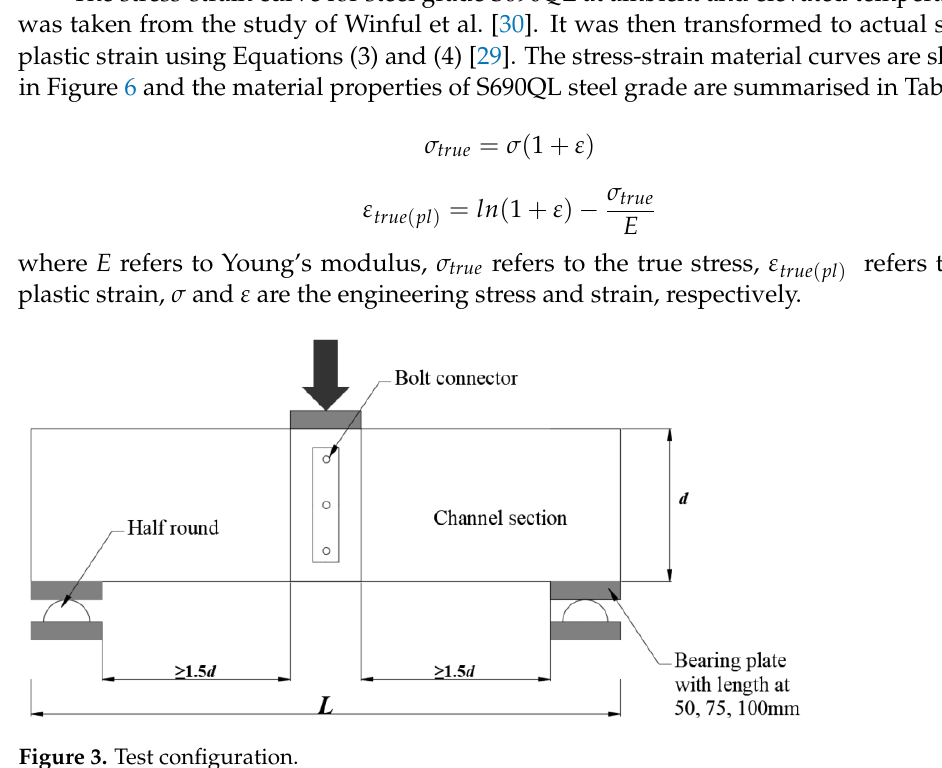
Table 1. Coefficients for fastened and un-fastened channels under EOF load case [10].